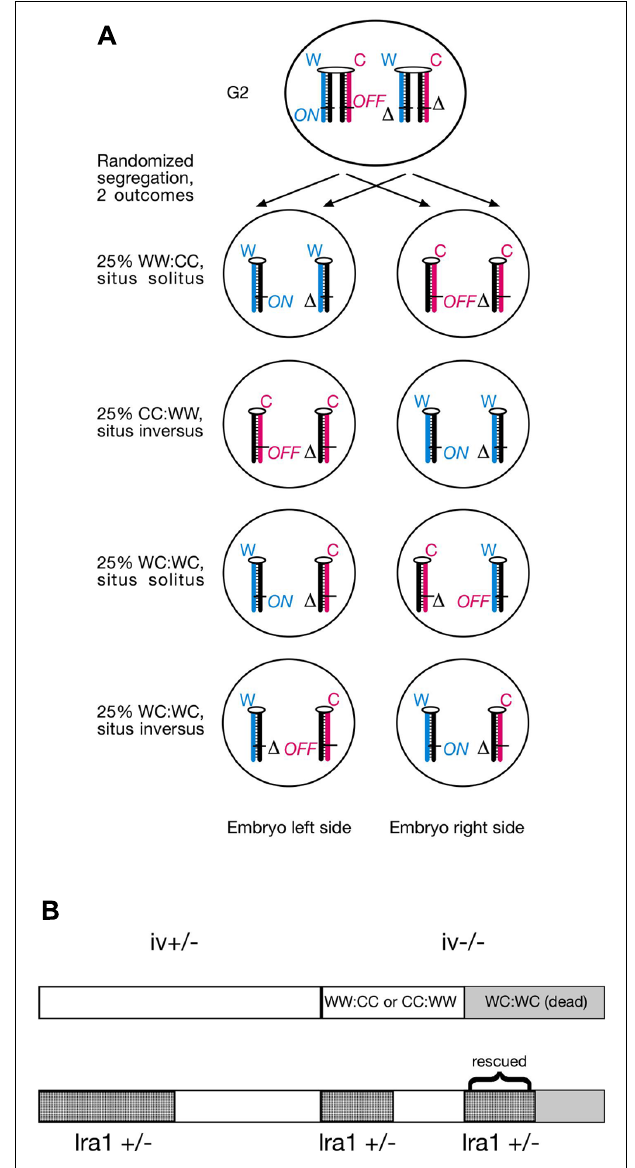
FIGURE 3 | (A) Lra1 heterozygosity is predicted to rescueWC:WC segregants that occur in lrd mutants. As illustrated in Figure 2, SSIS predicts 50% lethality in lrd mutants due to occurrence ofWC:WC segregation at 50% incidence. Lethality is due to conflicting ( ON and OFF ) lra1 epialleles in cells that inherited both olderWatson and older Crick template strands. However, in compound lrd homozygous and lra1 heterozygous mutant embryos,WC:WC segregants are predicted to survive.This is because lra1 has only one functional allele, the lethality-causing ON/OFF combination in both sister cells described in Figure 2 cannot be generated.Therefore, a 50:50 distribution of situs solitus and situs inversus animals is expected to develop. Symbols: Δ , deletion of lra1 ( = Nodal ?); rest of symbols are as described in Figure 1A. (B) SSIS-predicted ratios of genotypes from an iv + / − X iv − / − cross (top) and an iv + / − , lra1 + / − X iv − / − , lra1 + / + cross (bottom). Conventionally 50% offspring is expected to be lra1 + / − . BecauseWC:WC segregants (gray) are predicted not to die if they are also lra1 + / − , lra1 + / − animals should be overrepresented in the offspring by a 4:3 ratio. Moreover, iv − / − are predicted to occur at a 3:4 ratio as opposed to 1:2 (top), and lra1 + / − , iv − / − animals are also predicted to occur at increased rates